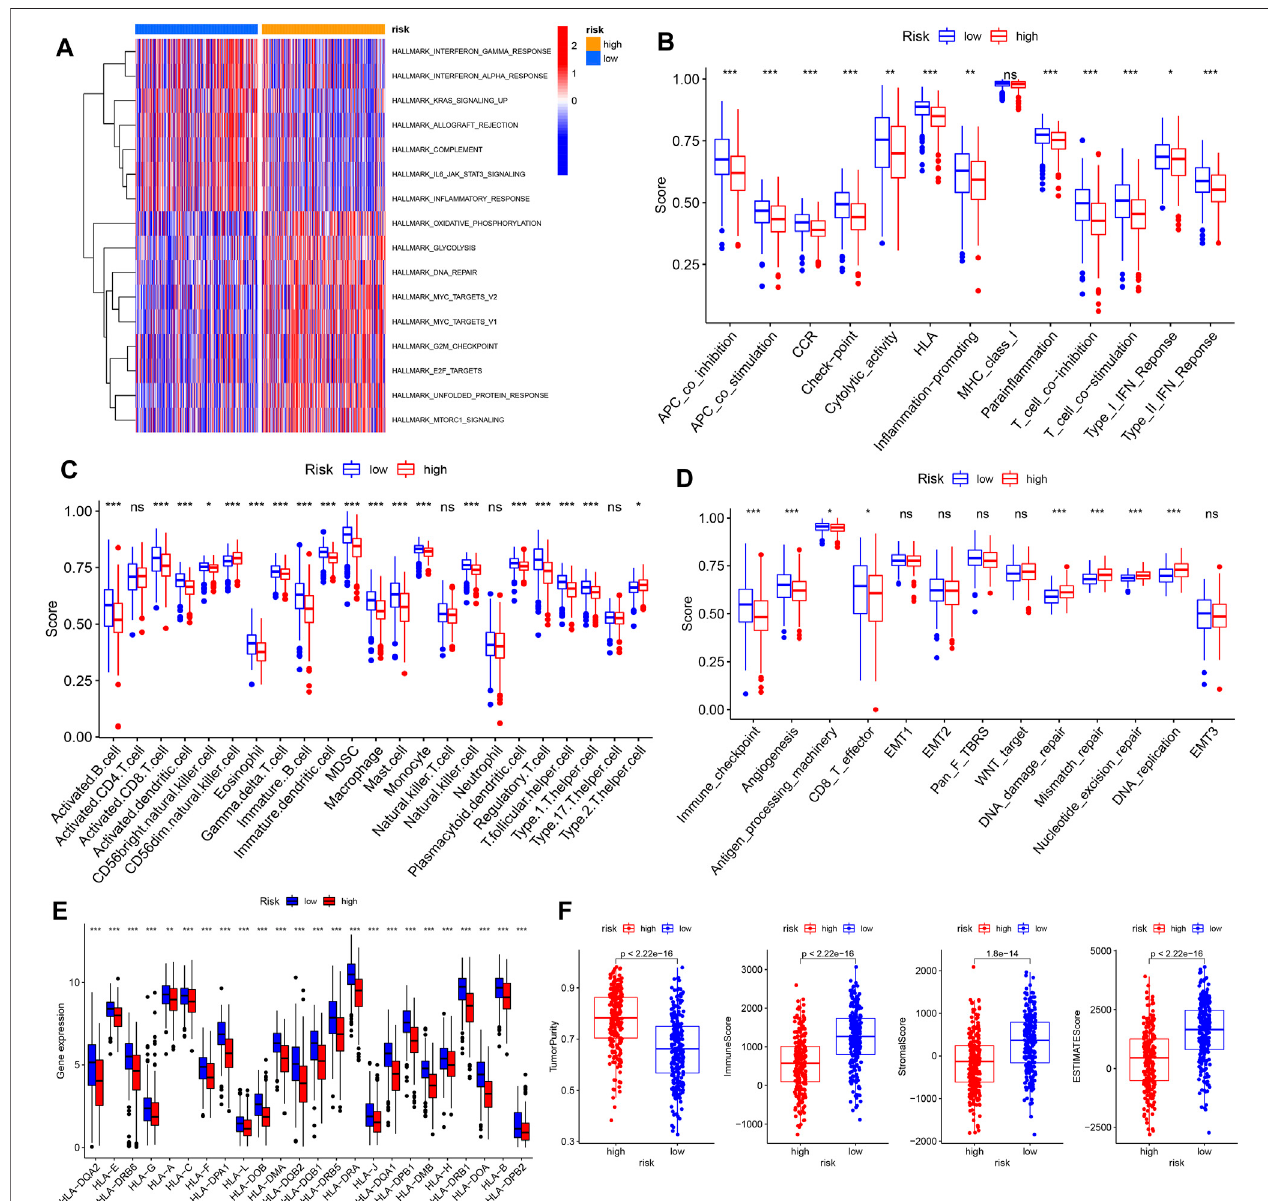
FIGURE5| Differences inlandscapeoftheTMEbetweenhigh-andlow-riskgroups. (A) GSVAenrichmentanalysisoftumorhallmarkpathways. (B – E) Differences in immune-related functions, TME in fi ltrating immune cells, other tumor-related functions, and HLA-related gene expression in the high- and low-risk groups. (F) Comparison of tumor purity, immune score, stromal score, and ESTIMATE score between high- and low-risk groups. TME, tumor microenvironment, * p < 0.05; ** p < 0.01; *** p < 0.001; ns, not statistically signi fi cant.